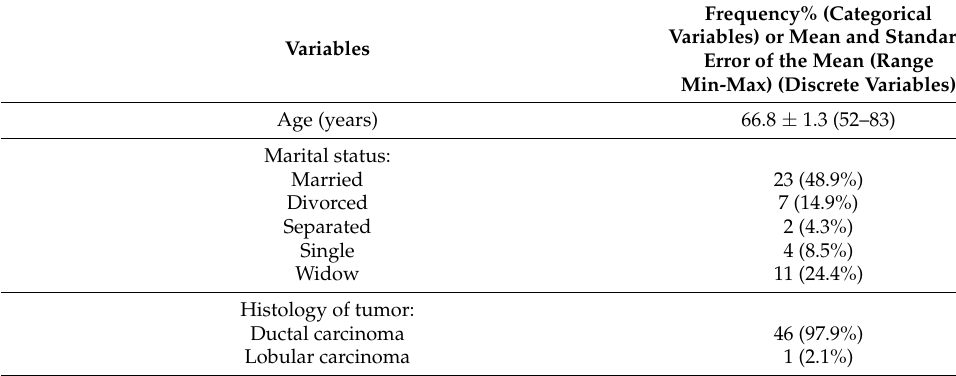
Table 1. Sociodemographic and clinical